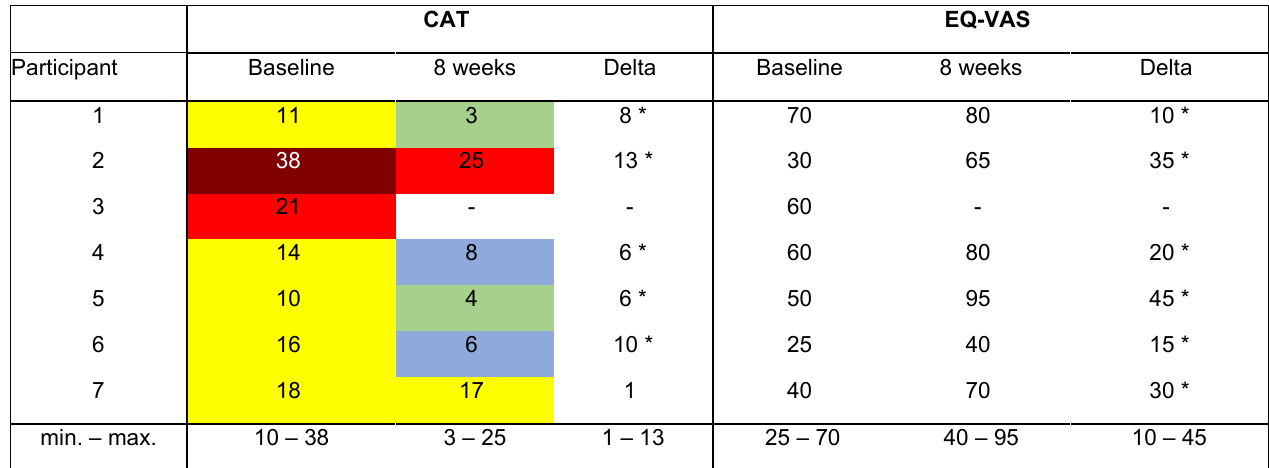
Preliminary Impact of the Intervention on Core Outcomes